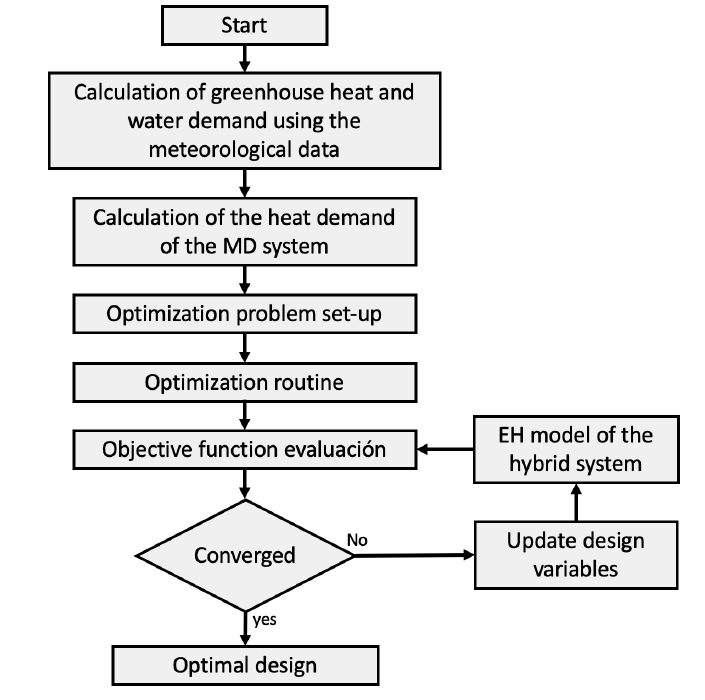
Figure 4. The solving flowchart